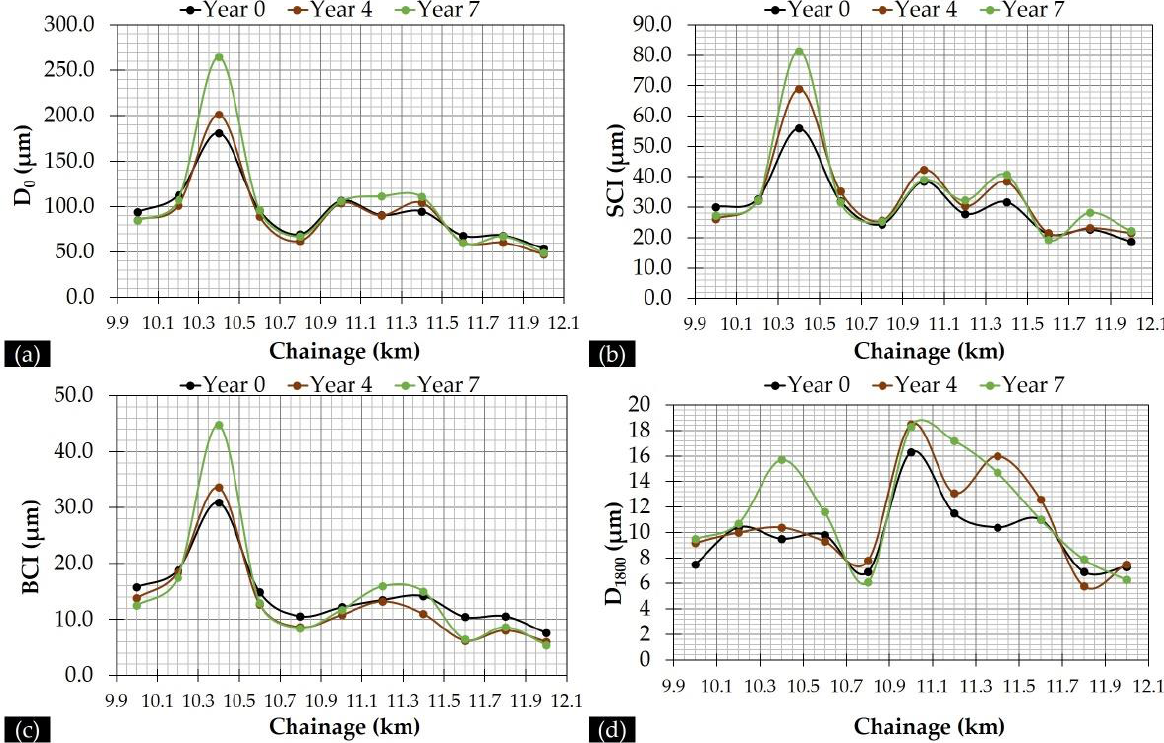
Figure 9. Deflection indexes: ( a ) D 0 , ( b ) Surface Curvature Index (SCI), ( c ) Base Curvature Index (BCI) and ( d ) D 1800 .